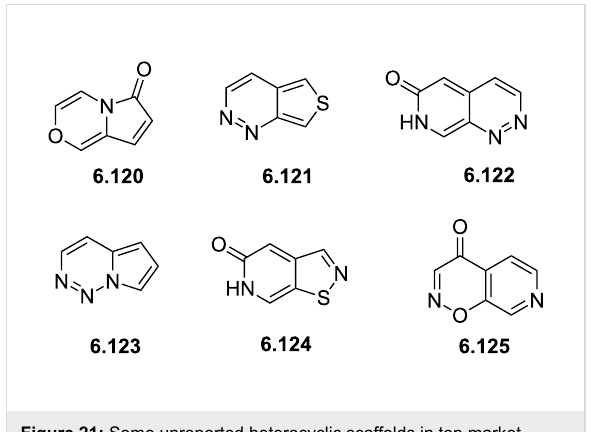
Figure 21: Some unreported heterocyclic scaffolds in top market